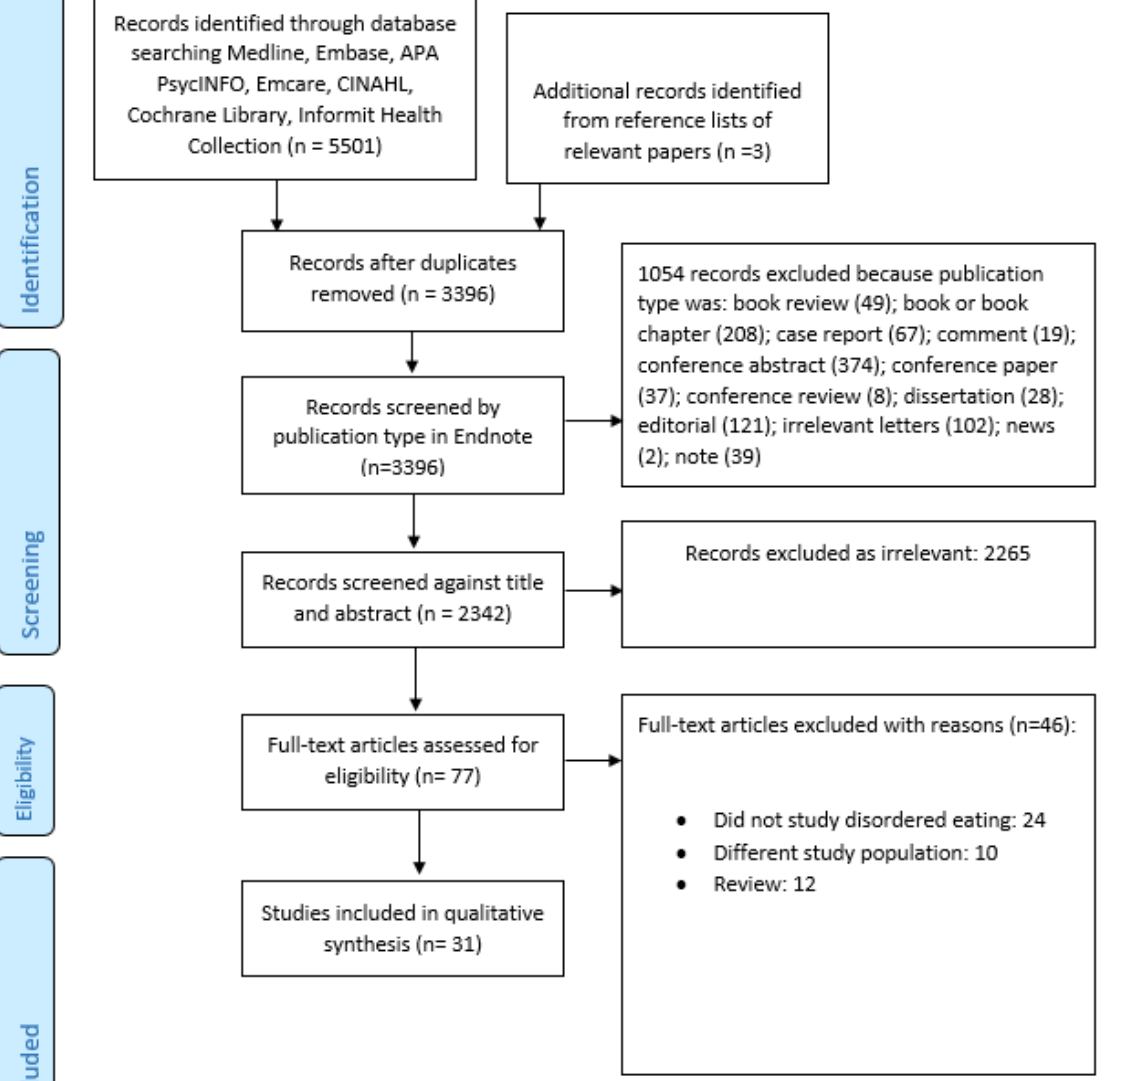
Figure 1. PRISMA flow